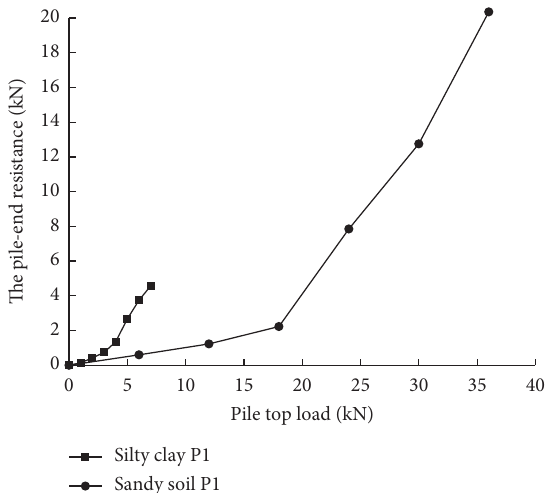
Figure 7: The lateral friction of pile with different diameters in soil samples along with load